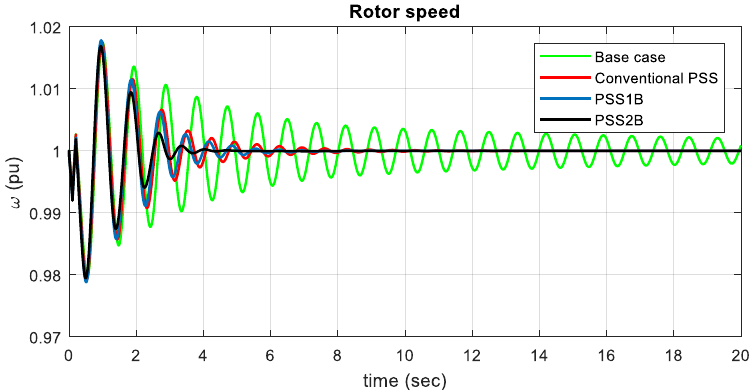
Figure 20. Generator rotor speed ( 𝜔 ) of the power system at heavy loading